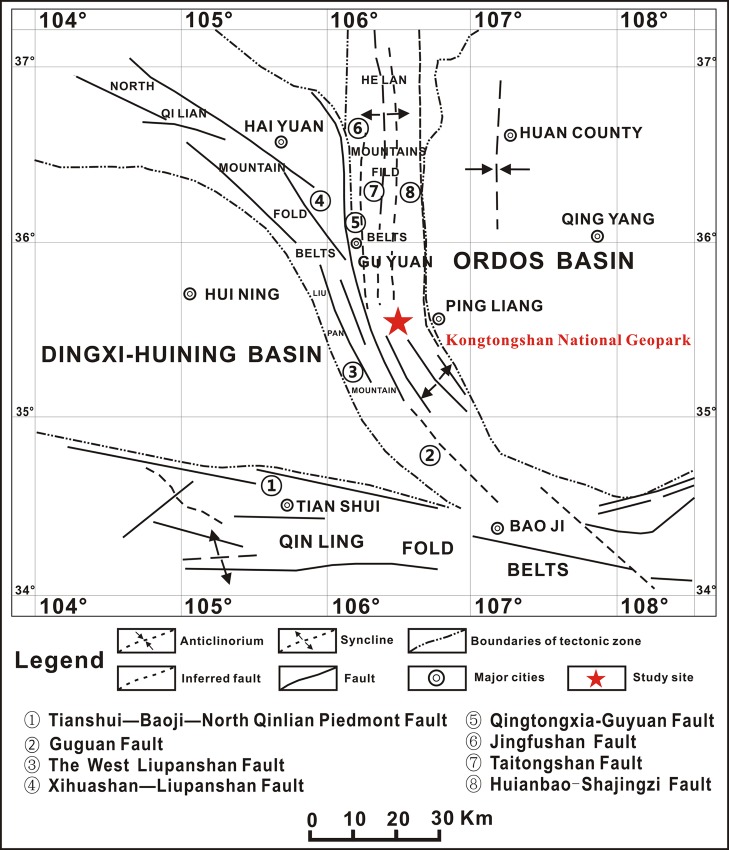
Geological structure map of Kongtongshan National Geopark (KNG).Fig 2 is excluded from this article's CC-BY license. See the accompanying retraction notice for more information.